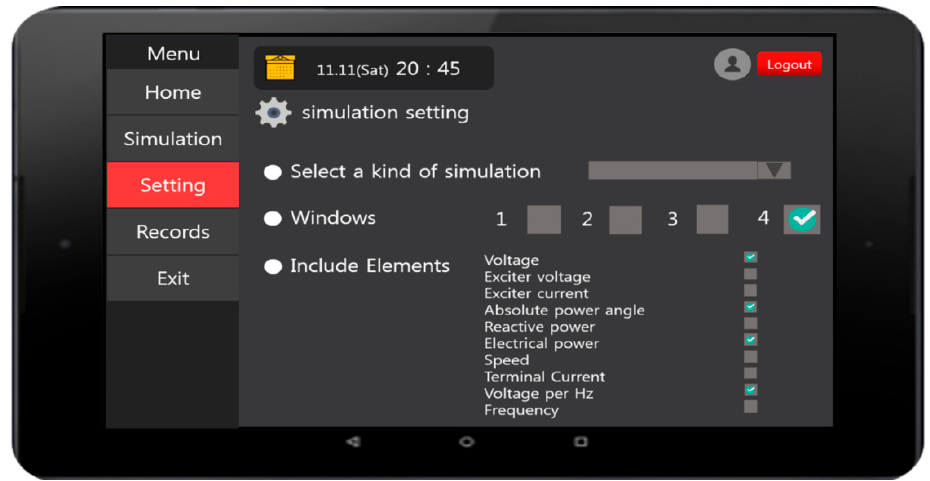
Figure 37. The user interface pertaining to the application setting.